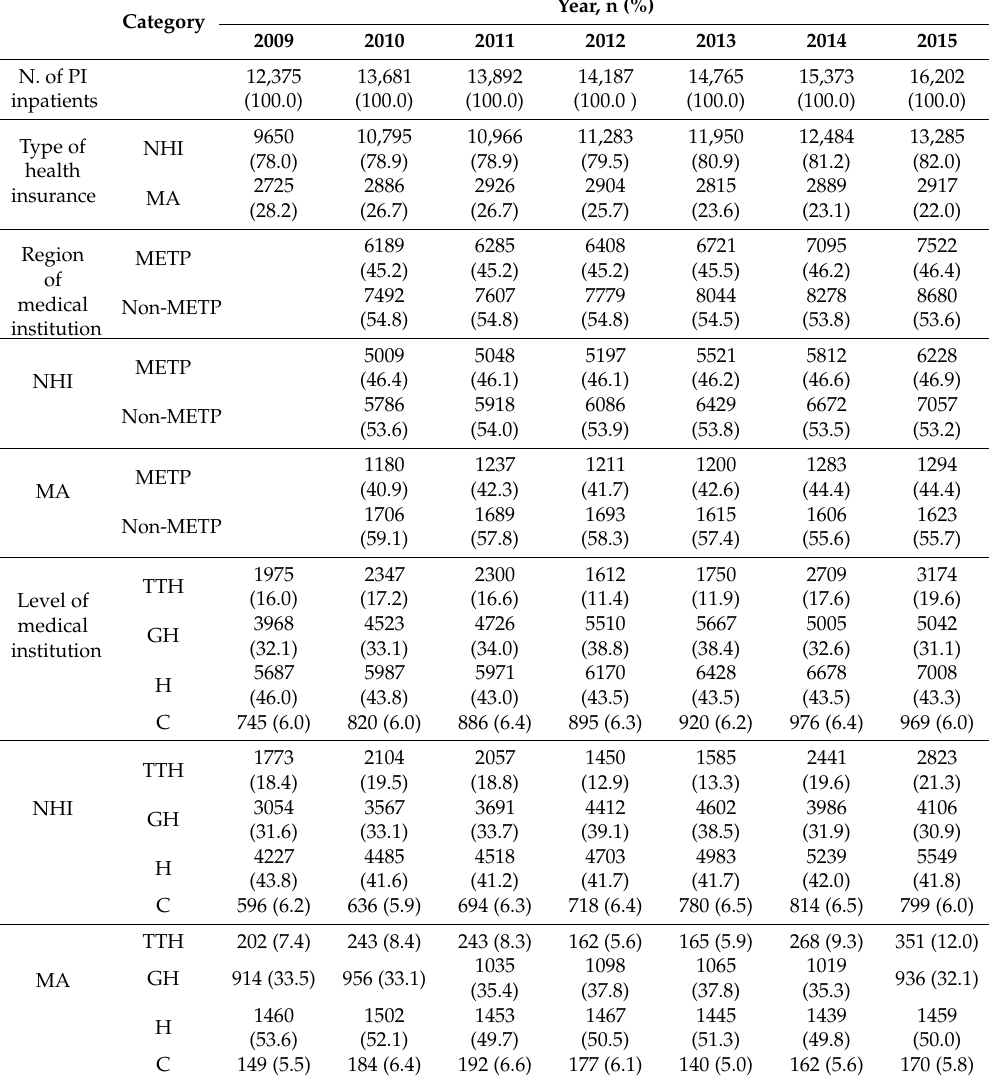
Table 2. Number of PI inpatients by the type of health insurance, regional location and level of medical